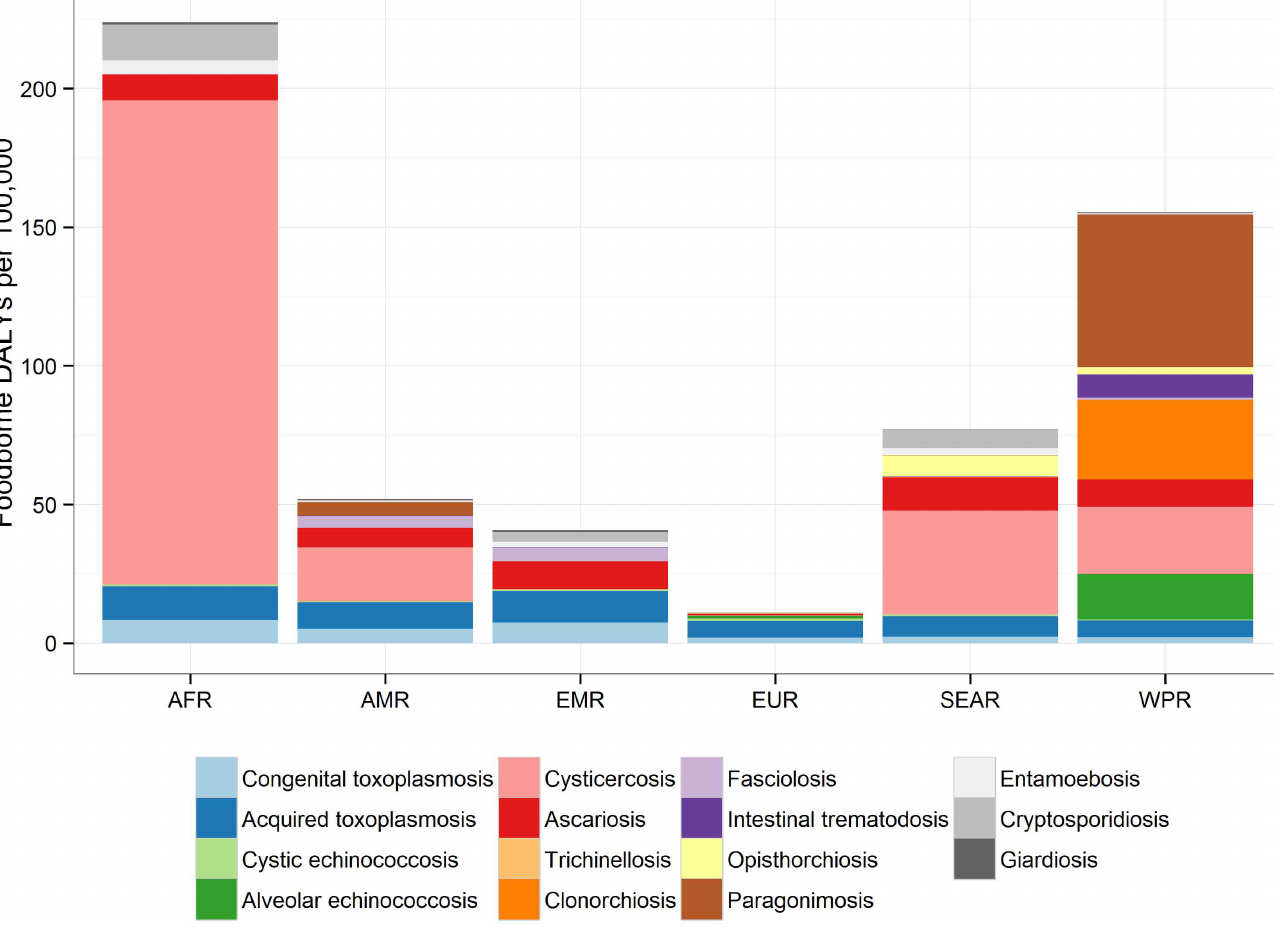
PLOS NeglectedTropical Diseases | https://doi.org/10.1371/journal.pntd.0005478 April 20,